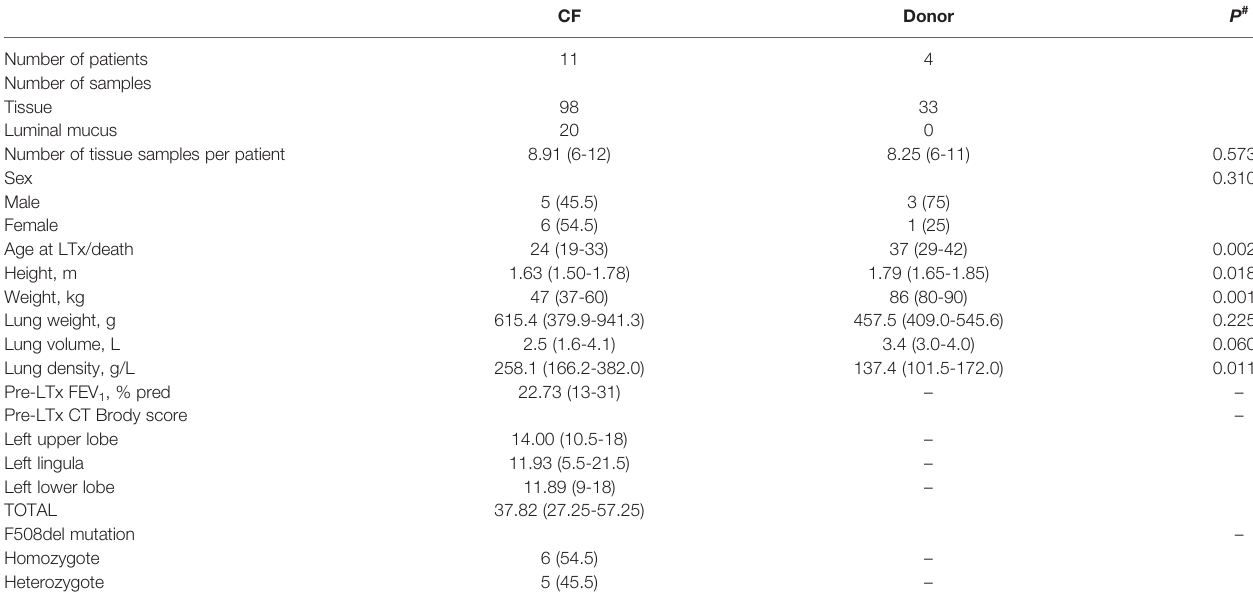
TABLE 1 | Demographics and clinical characteristics of participants in the